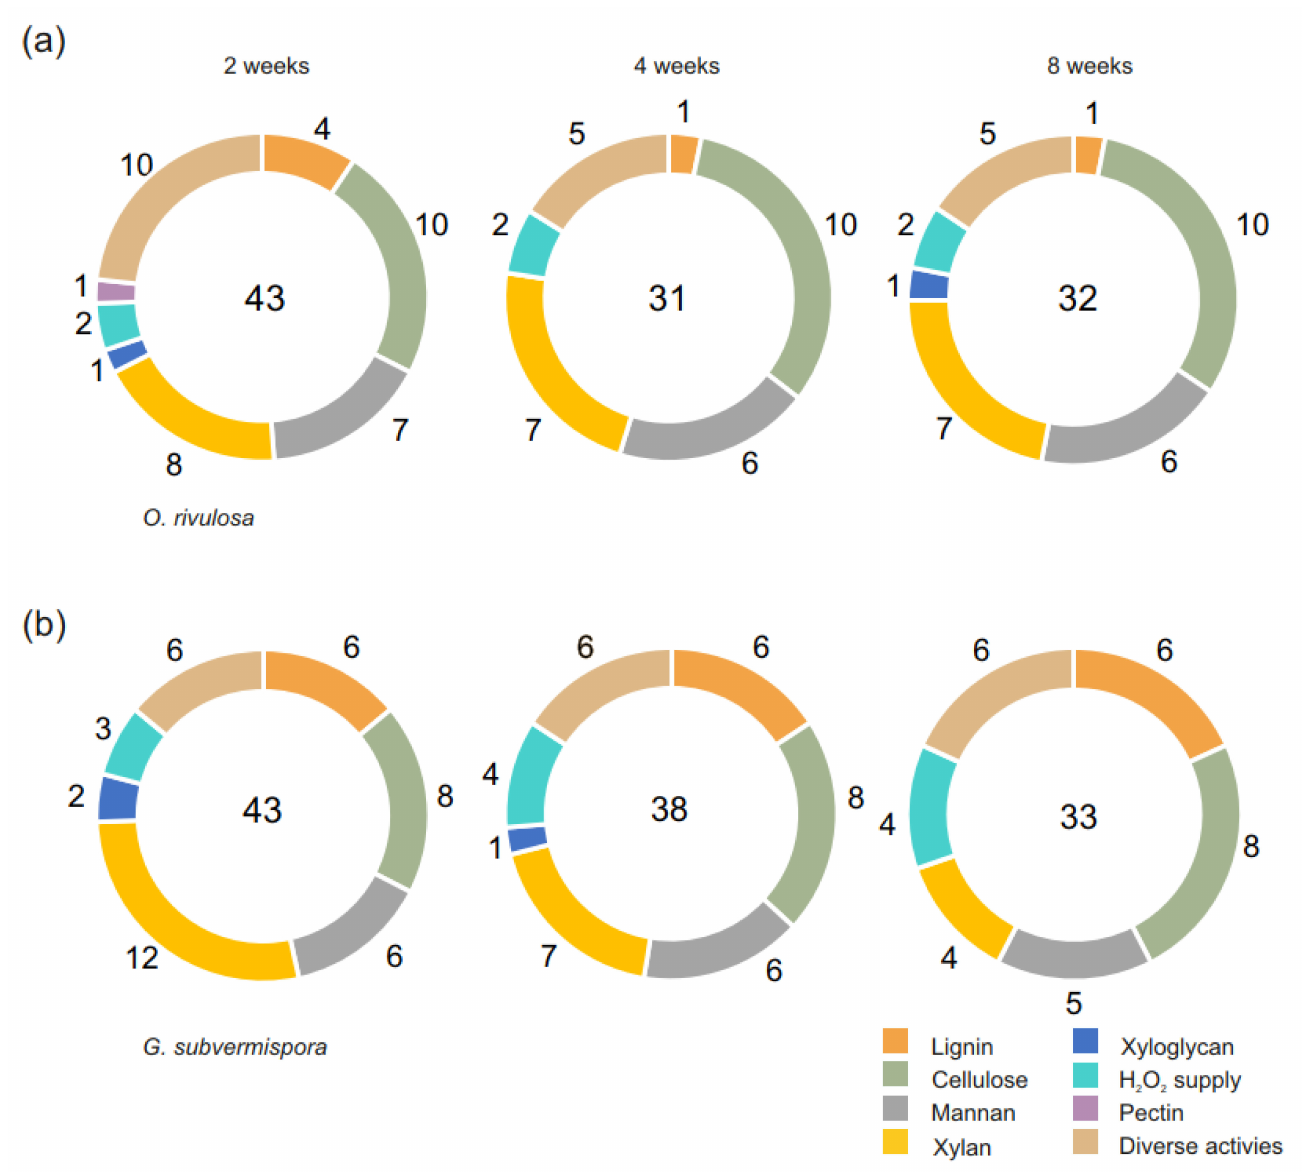
Figure 1. Functional distribution of detected predicted plant cell wall degrading CAZymes in spruce wood cultures of ( a ) O. rivulosa and ( b ) G. subvermispora on week 2, 4, and 8. Numbers in the center of the circles show the sum of detected plant cell wall degrading CAZymes in the specific time point. Numbers outside the circles display detected PCWDEs acting on their (putative) substrates at each time